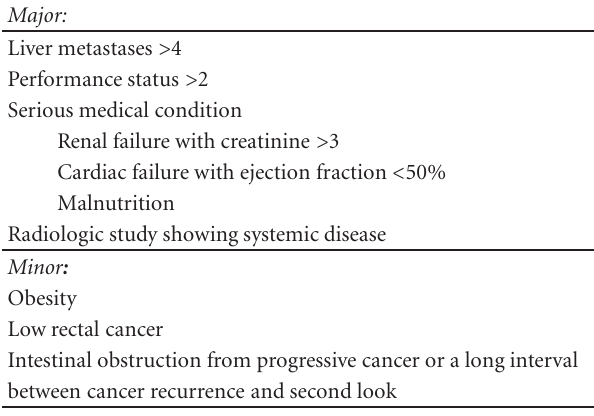
Table 3: Ineligibility requirements in patients considered for second-look